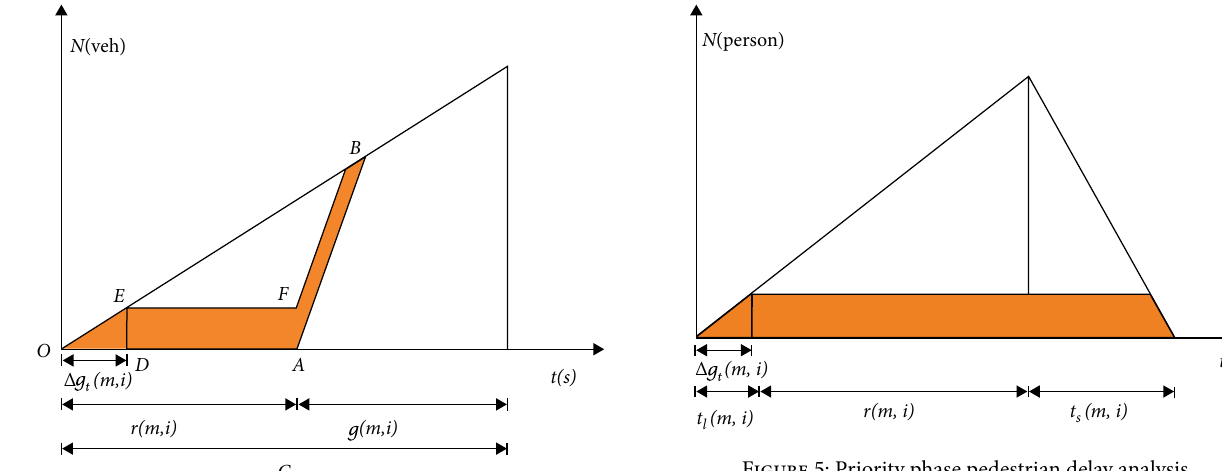
Figure 5: Priority phase pedestrian delay analysis.